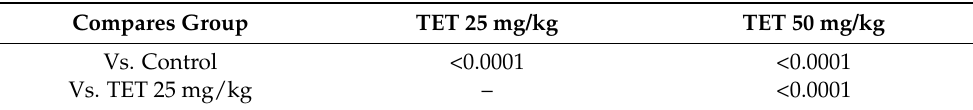
Table 2. The accurate p -value in Figure 3C is displayed. Here we summarized the p -value between control and two treatment groups of tumor weight.